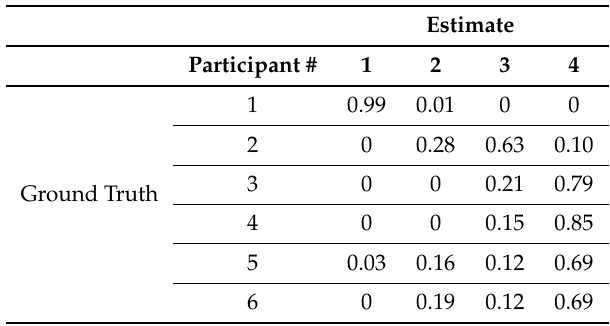
Table 13. Confusion matrix for identification based on a naive Bayesian classifier approach applied to RSS data from the 868 MHz network.